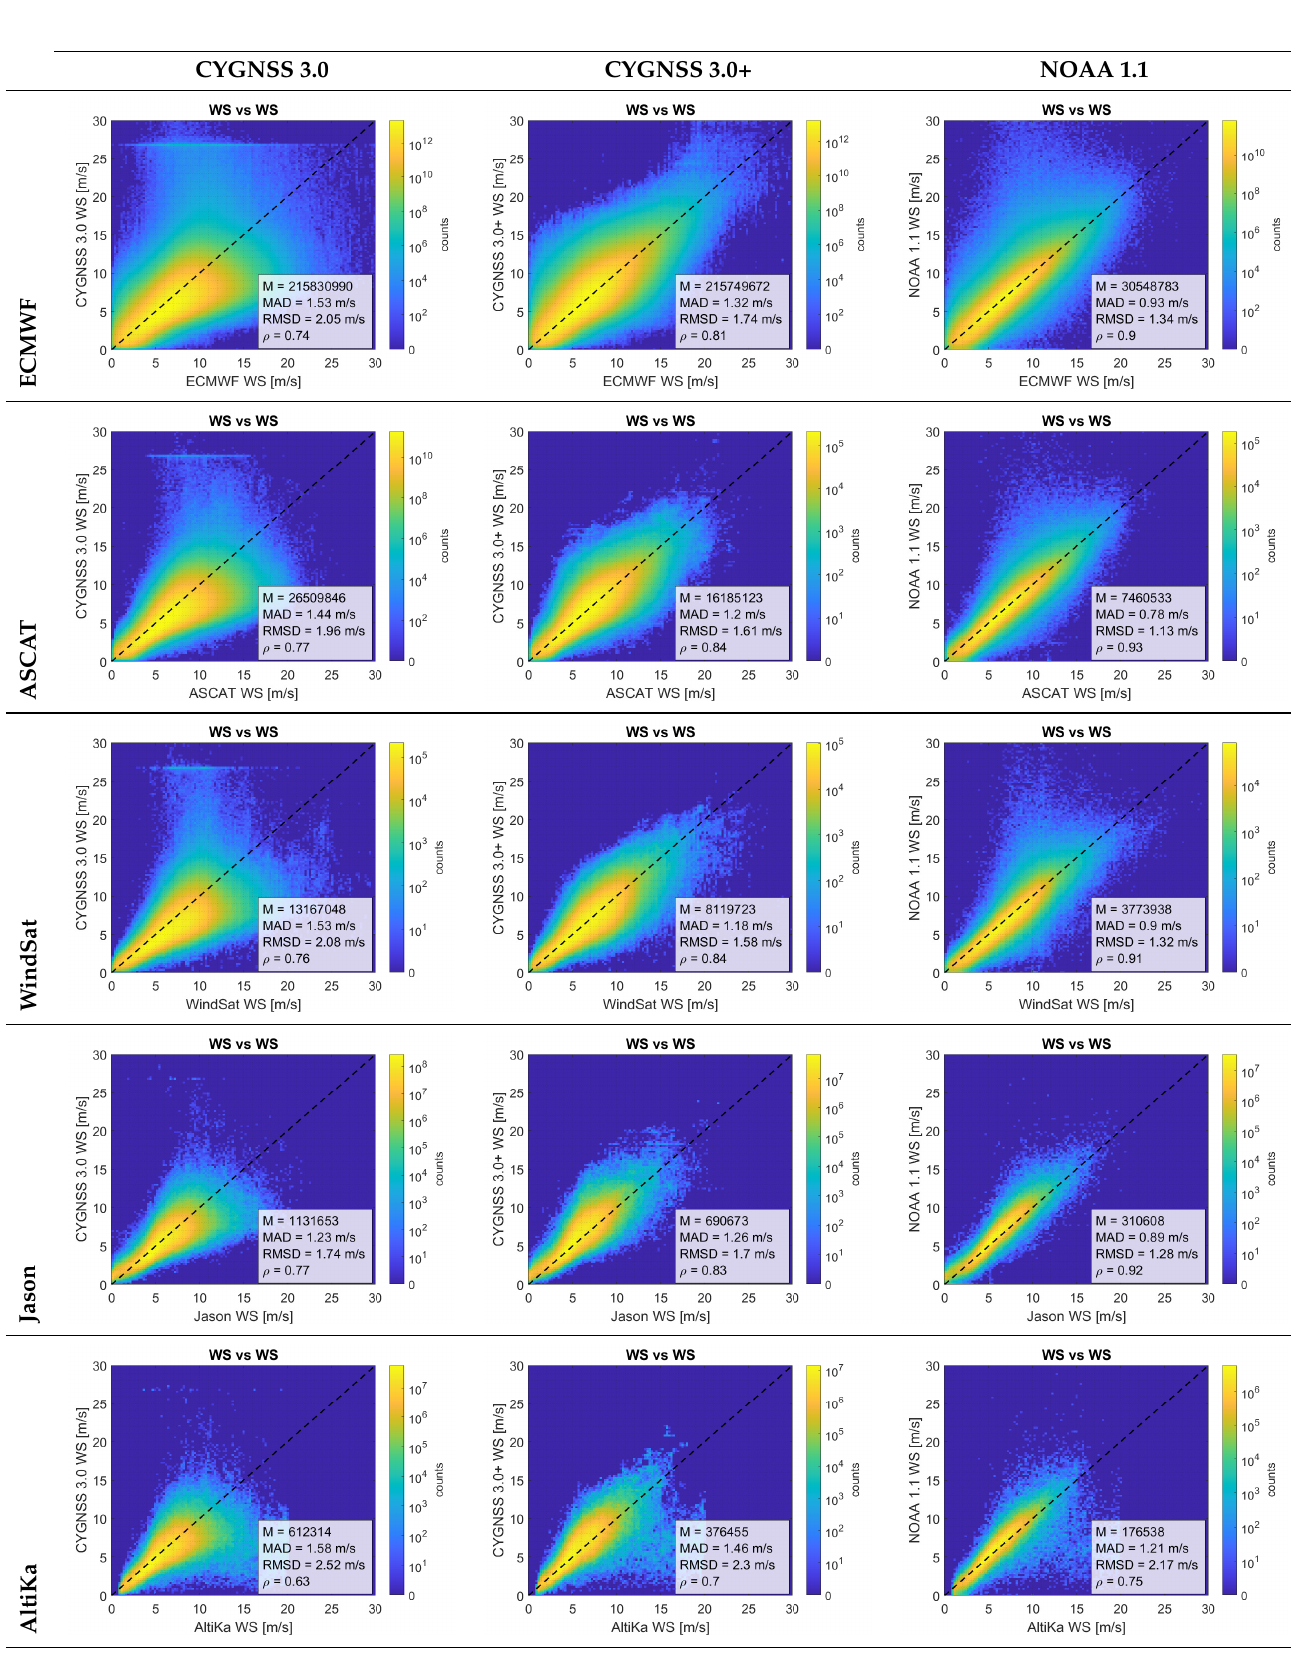
Figure 4. Histograms of different CYGNSS wind speed estimates (columns) vs different reference wind speeds (rows). The inner boxes show the metrics given in Table